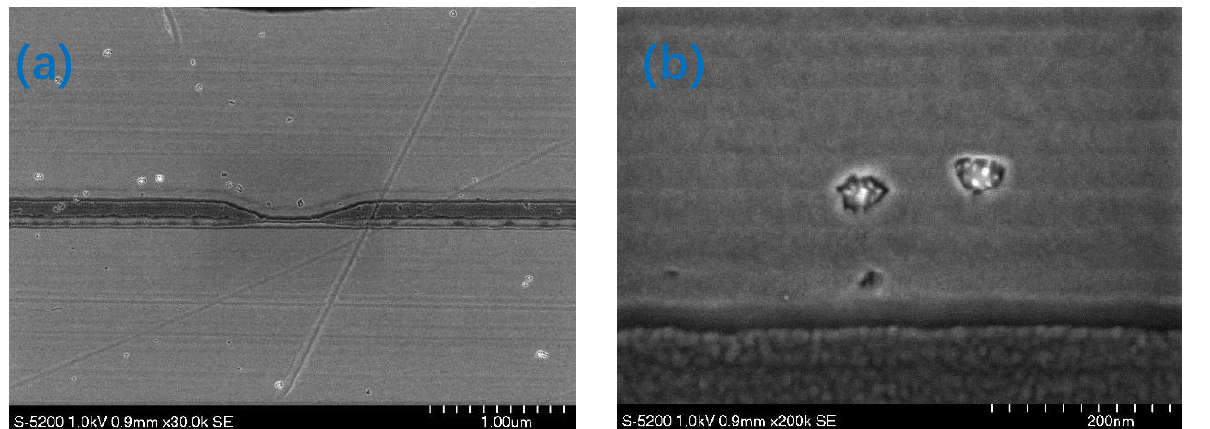
Figure 11. Super-SEM image of the black spots with different measurement range: ( a ) 1.00 µ m; ( b ) 200